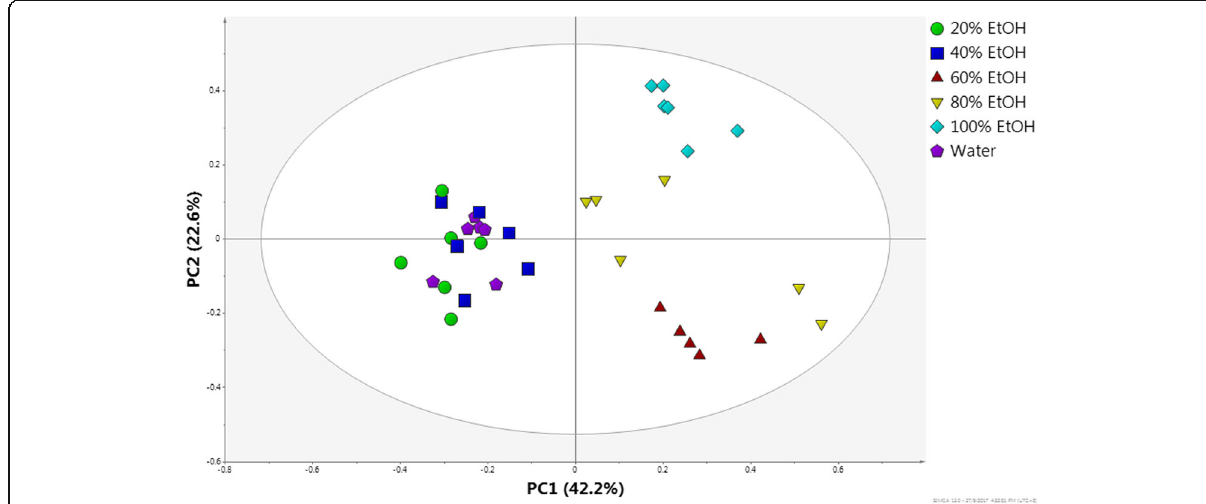
Fig. 2 PCA score plot of the 1 H NMR data of the various EtOH:water extracts